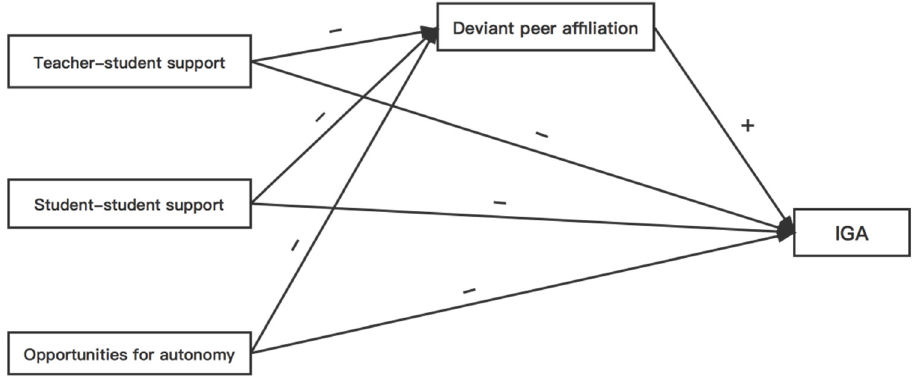
Figure 1. The conceptual model of perceptions of school climate, deviant peer affiliation and adoles- cent IGA.